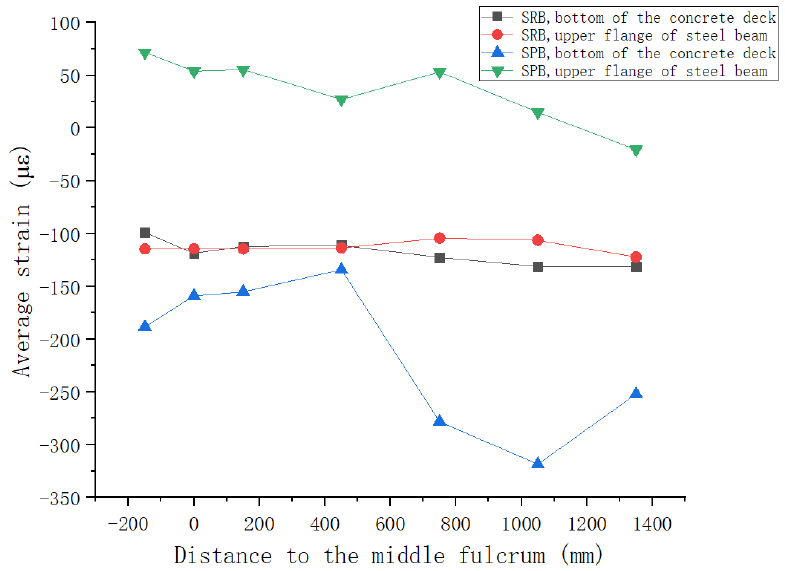
Figure 12. Longitudinal Distribution of Fiber Strain Values Adjacent to the Interface of Steel–concrete for 7 Cross-Sections.